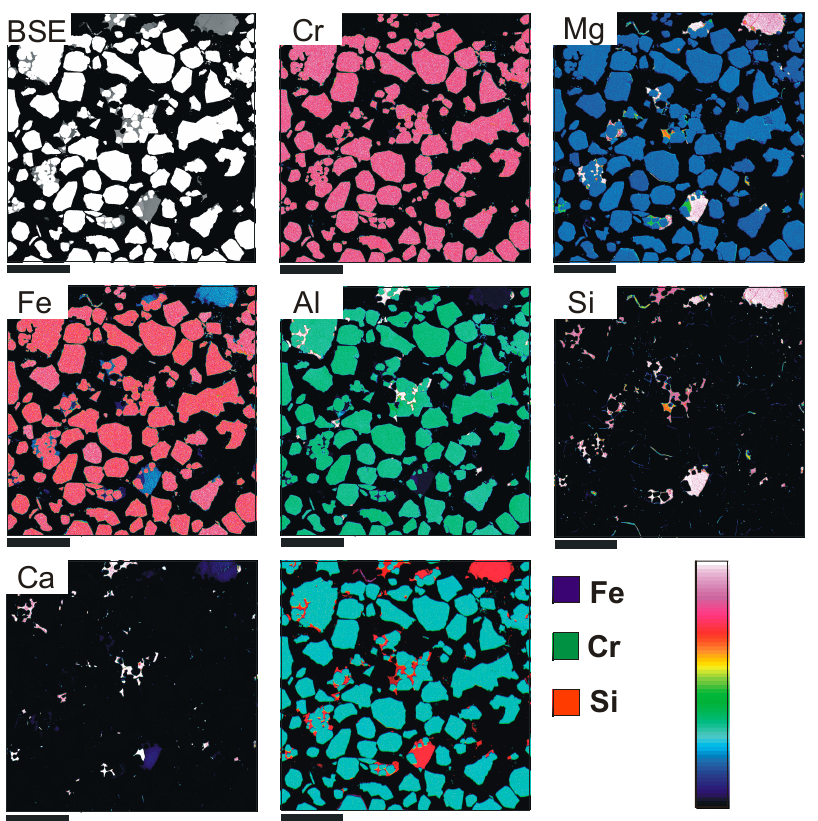
Figure 3. Back-scattered electron (BSE) selected individual element concentration maps and a composite map for the − 2 mm bulk sample. The scale bar beneath each image indicates a size of 1.0 mm, while the colored bar at bottom right indicates the relative concentration of each element.